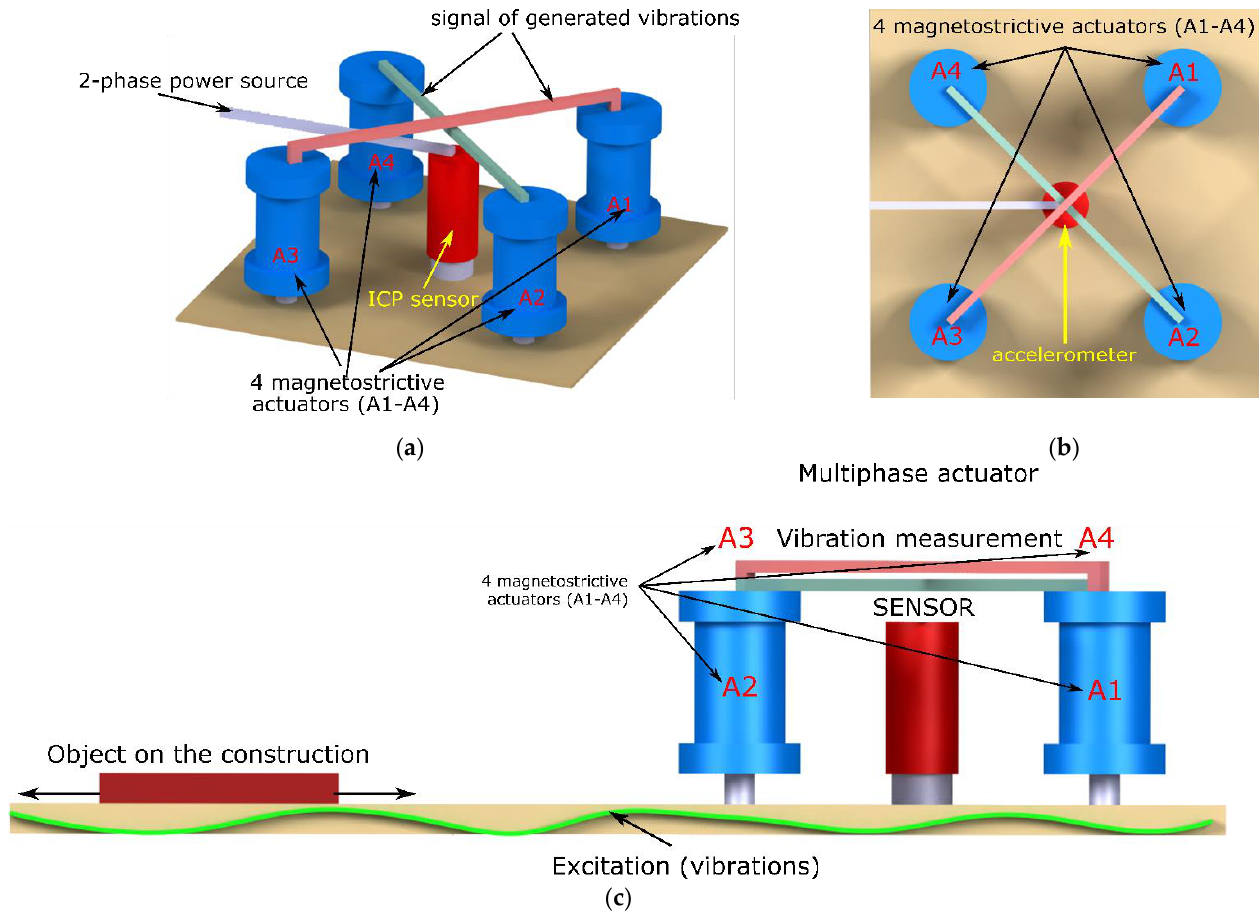
Figure 2. The idea of the four magnetostrictive actuators (A1 – A4) system: ( a ) actuators operating simultaneously with vibration measurement path; ( b ) symmetrically distributed actuators; ( c ) linear positioning system using vibration.